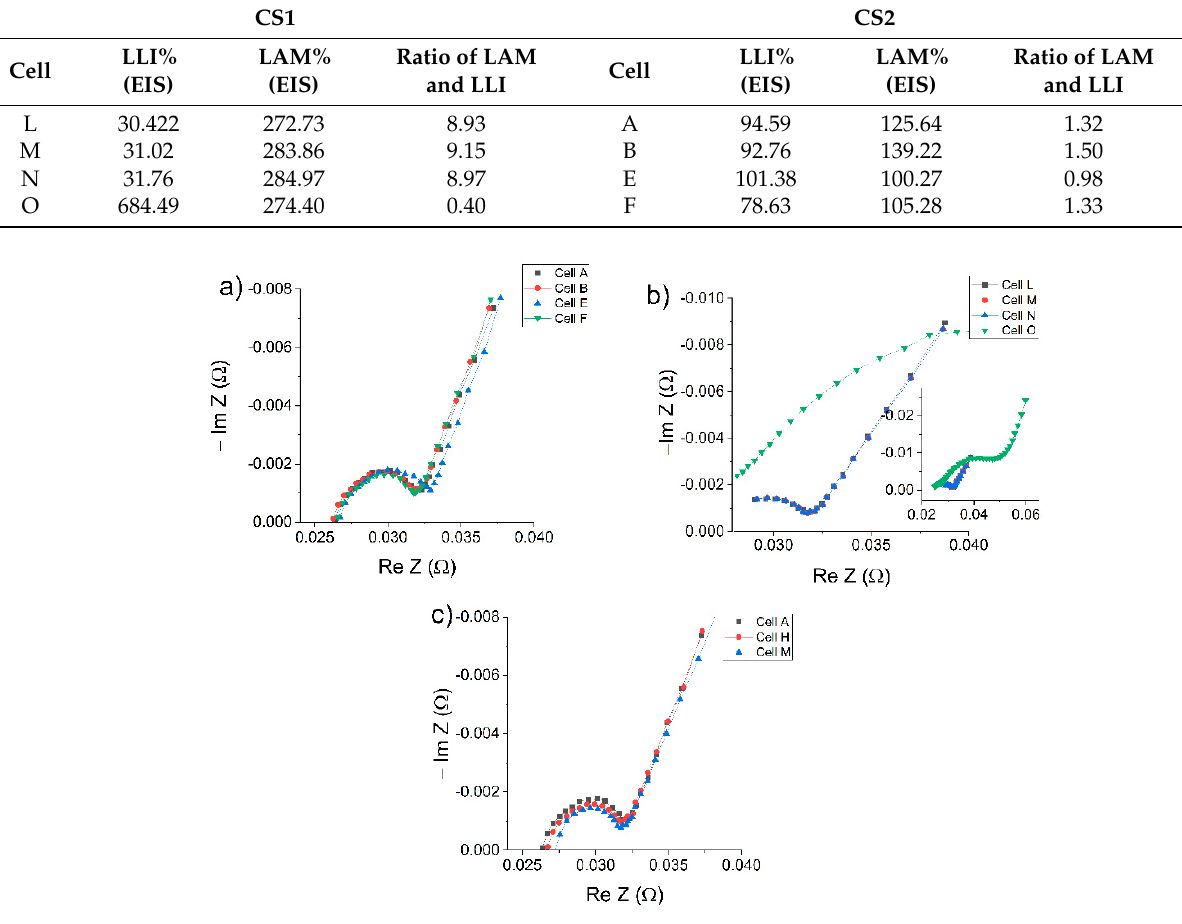
Figure 5. Nyquist plot for ( a ) CS1 ( b ) CS2 and ( c ) Different DM cells.